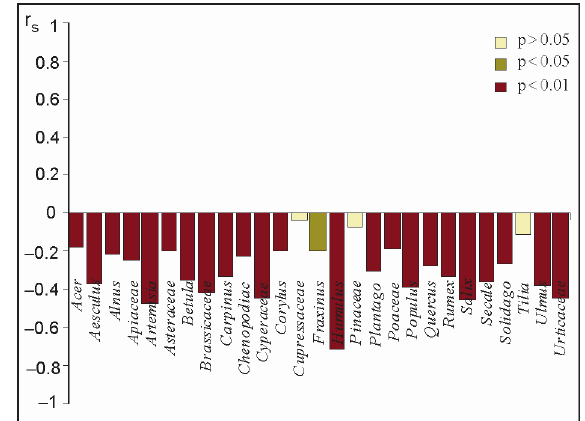
Fig. 2. Correlation coefficients (r s ) of plants pollen concentra- tion of various genera and families during the pollen season and air temperature in 2004 – 2009